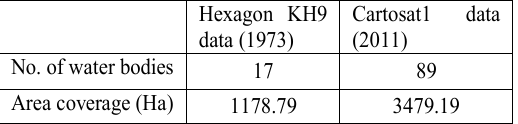
Table 2. Number of water bodies and the area covered in